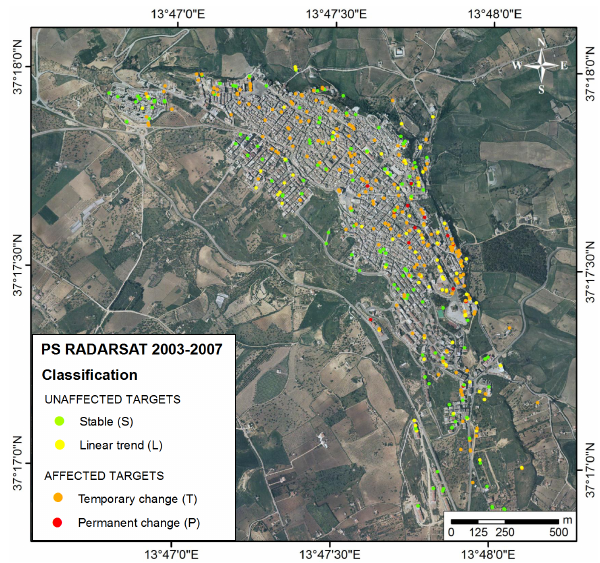
Fig. 11. Classification of RADARSAT PS time series according to the different behaviours with respect to the 2005 event, as defined in Fig. 2: unaffected (classes S and L) and affected targets (classes T and